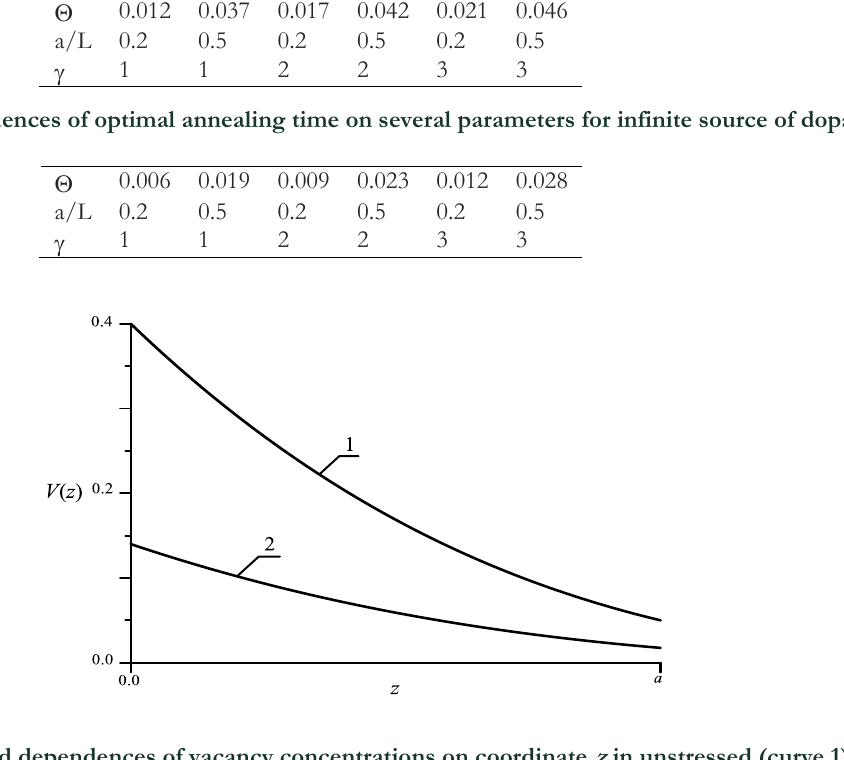
Fig. 9. Normalized dependences of vacancy concentrations on coordinate z in unstressed (curve 1) and stressed (curve 2) epitaxial